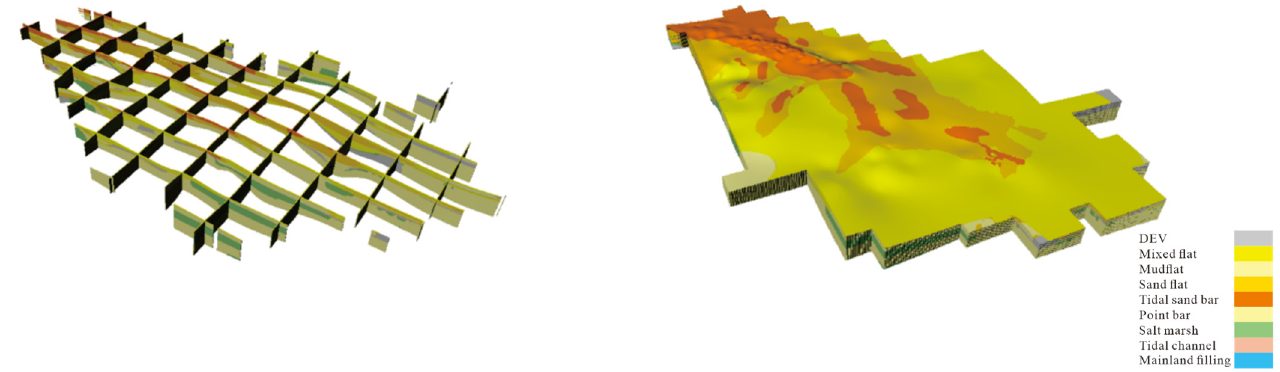
Figure 10. The 3D model of the study